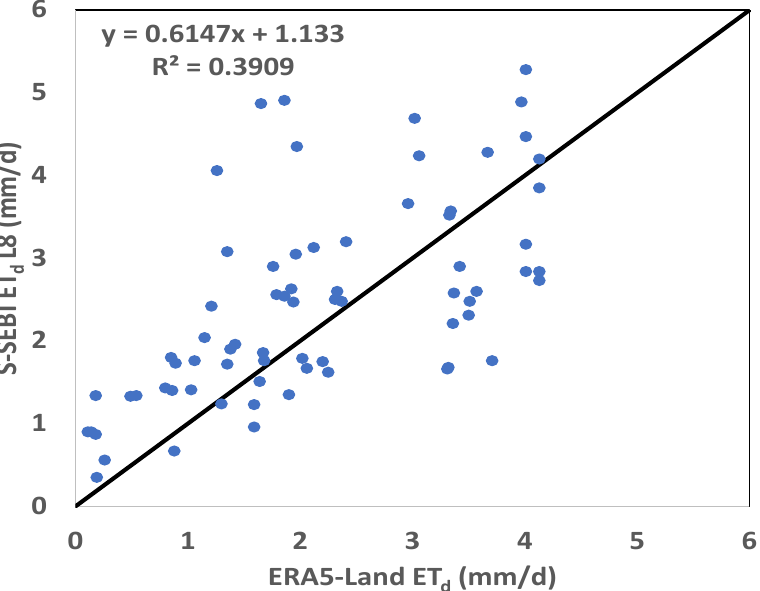
Figure 5. Comparison of total evaporation (TE) obtained from ERA5-Land reanalysis data and S-SEBI ET d values obtained from Landsat-8 inputs, after upscaling and geo-collocating the output scenes, all in mm/d.